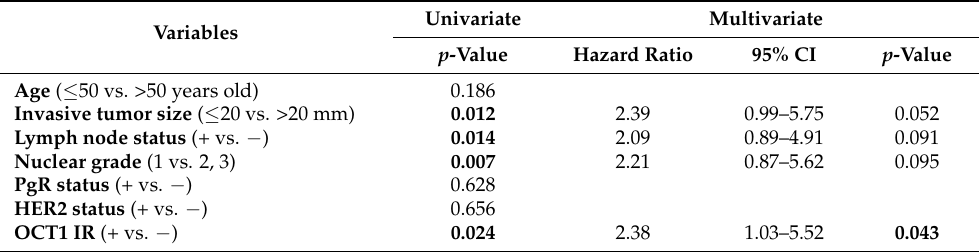
Table 2. Univariate and multivariate analyses of disease-free survival with clinicopathological parameters including OCT1 immunoreactivity in ER-positive breast cancer